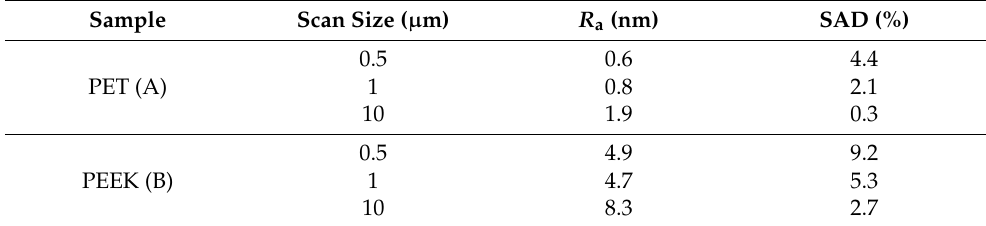
Table 1. AFM analysis parameters: average surface roughness ( R a ) and surface area difference (SAD) for ultramicrotome-cut PET and PEEK samples. The parameters correspond to Figure